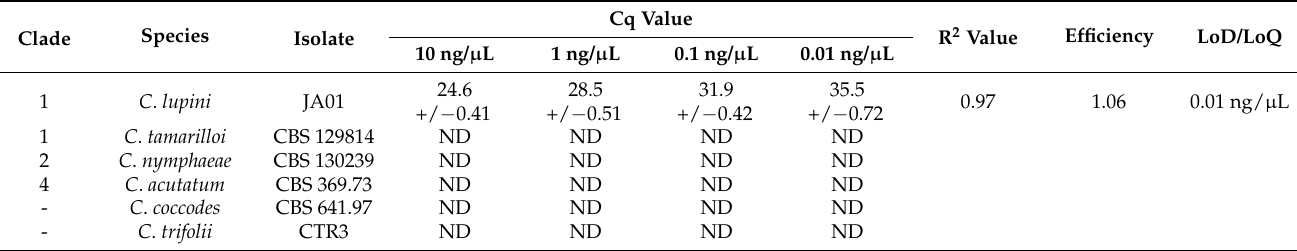
Table 1. Specificity, sensitivity, and efficiency of the C . lupini qPCR assay. Quantification cycle (Cq) values (+/ − standard deviation) are given for four 10-fold dilutions of C. lupini DNA standards for six different Colletotrichum spp., four of which belong to different clades of the C. acutatum species complex. R 2 is the coefficient of correlation between Cq and DNA standard values. Sensitivity is expressed via the limit of detection and quantification (equal in this case). Clade